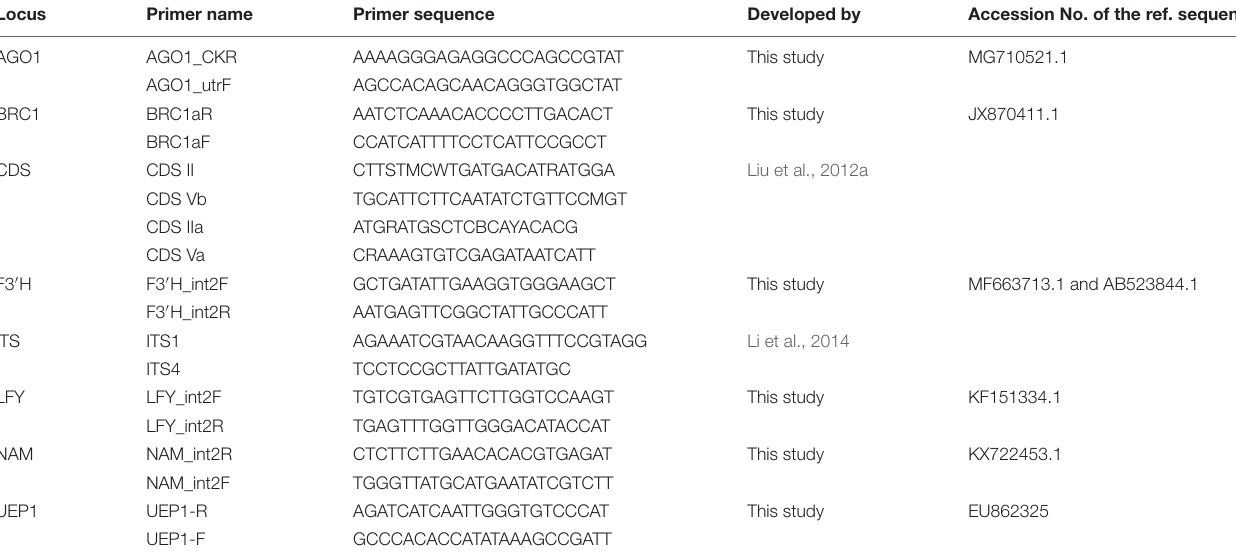
TABLE 2 | Sequence information of the present phylogenetic reconstruction. Dataset Locus Num. of